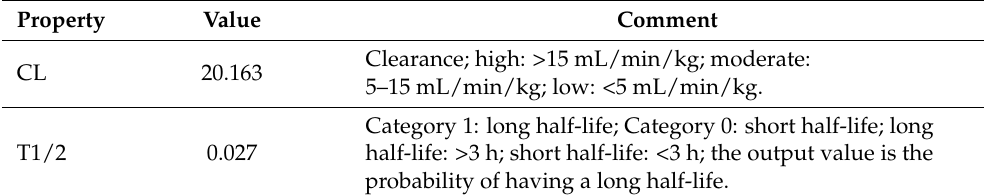
Table 11. The properties of the drug excretion of compound 1